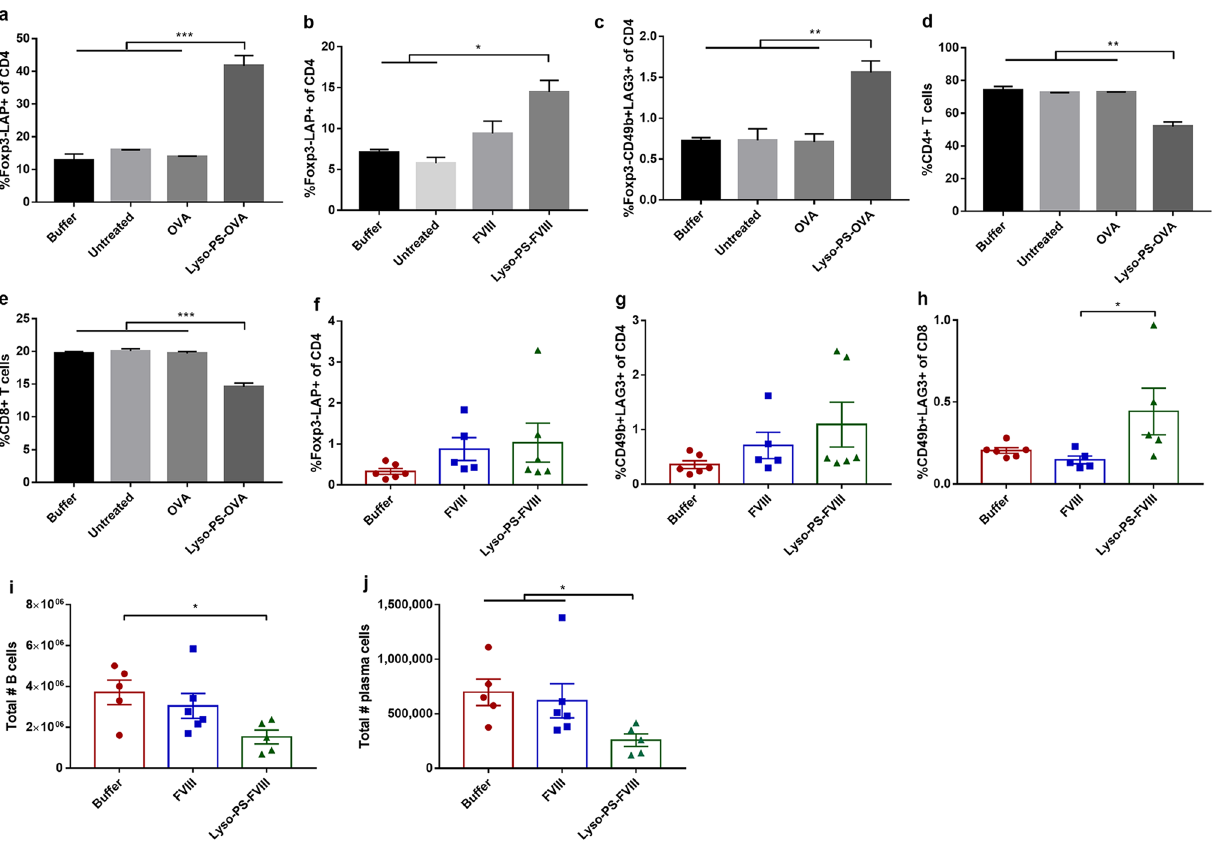
Figure 3. Cellular mechanisms of tolerogenic lipid particles. Expansion of LAP+ T regs ( a , b ) and Tr1 ( c ) following in vitro treatment with tolerogenic lipid particles, which led to the suppression of CD4+ ( d ) and CD8+ T cells ( e ). Data are represented as mean ± SD. Representative graphs from 2 independent experiments was shown. ( f – h ) Frequency of LAP+ T regs , Tr1, and CD8+ T regs co-expressing LAG3 and CD49b,